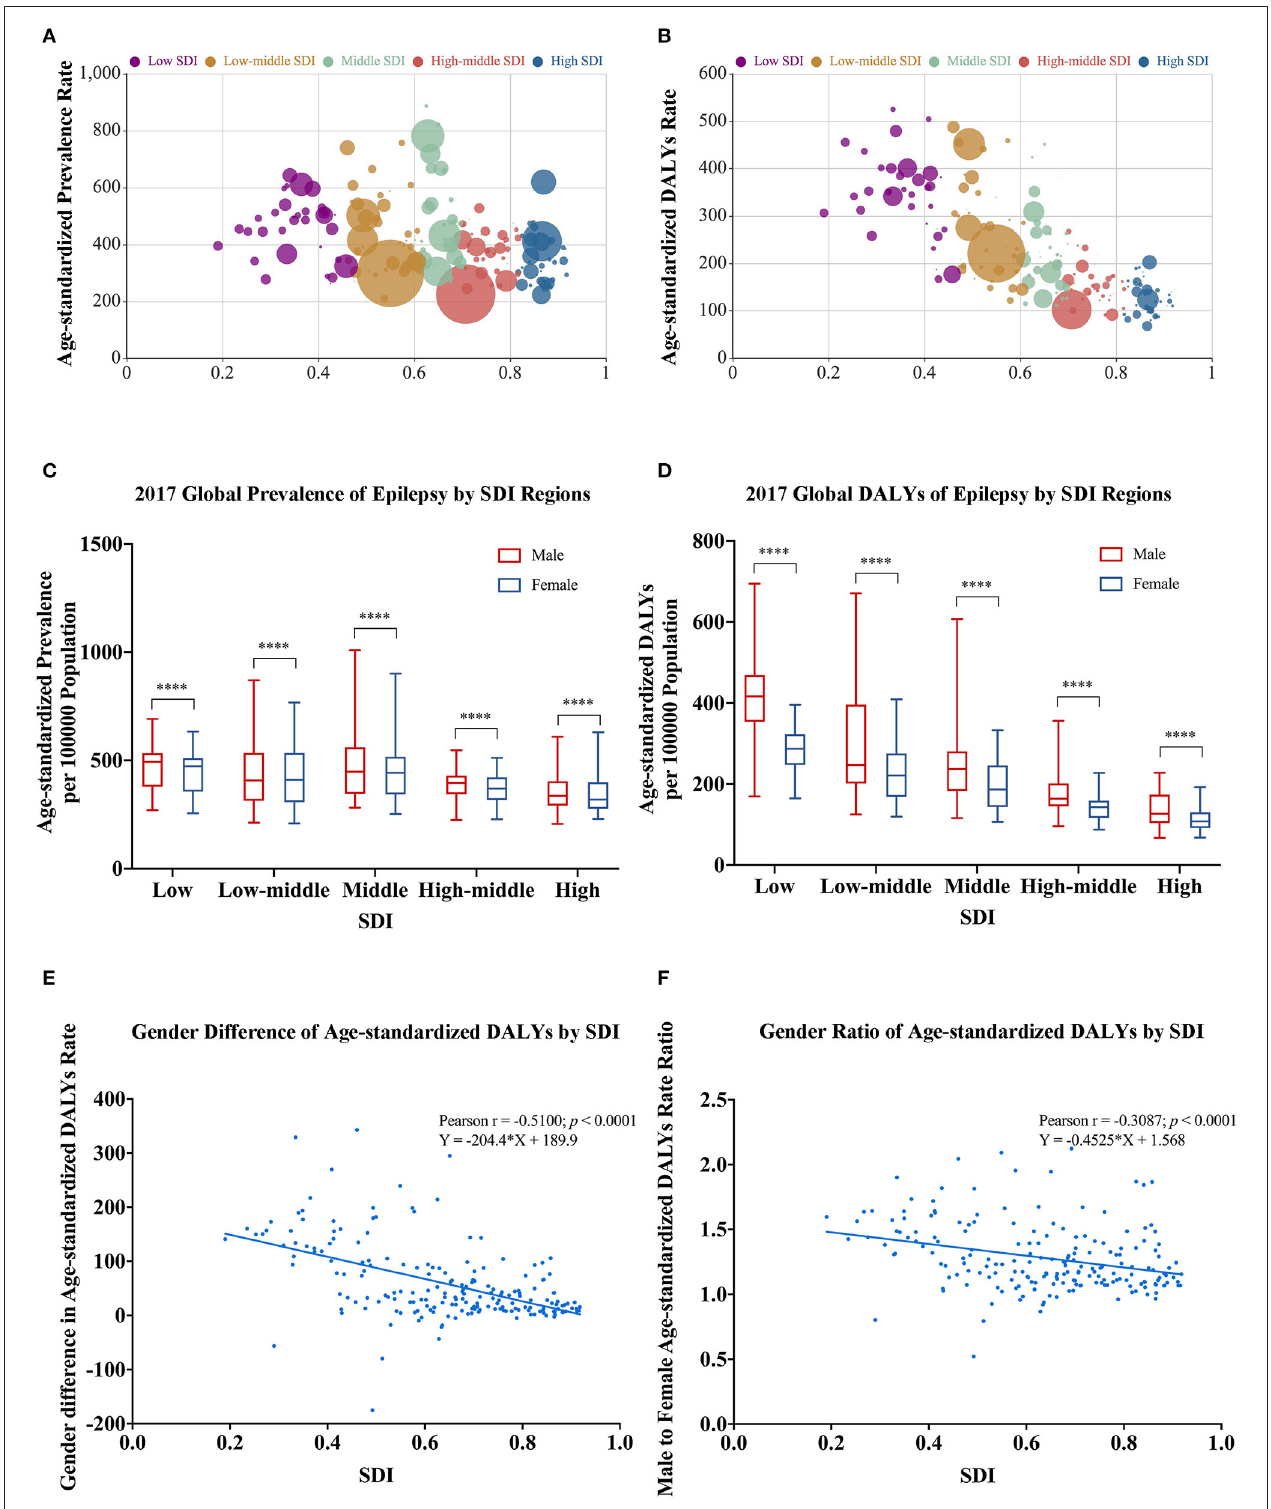
FIGURE 5 | Gender-specific burden of epilepsy in different SDI regions in 2017. (A) All-age prevalence number and age-standardized prevalence rate (the area of the bubble represents the prevalence number). (B) All-age DALY number and age-standardized DALY rate (the area of the bubble represents the DALYs number). (C) Age-standardized prevalence rate by sex in different SDI groups. (D) Age-standardized DALY rate by sex in different SDI groups. (E) Association of gender difference (male minus female) in age-standardized DALY rates with SDI. (F) Association of gender ratio (male to female) in age-standardized DALY rates with SDI. DALYs, disability-adjusted life-years; SDI, socio-demographic index. *For difference between sexes; **** p < 0.0001, paired Wilcoxon signed rank test.